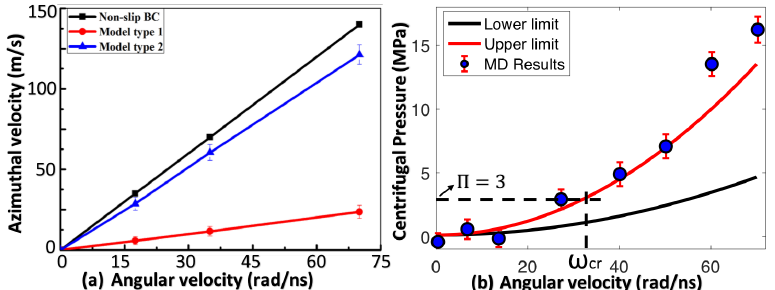
Figure 6. ( a ) Averaged azimuthal velocities of fluid near r = R i as a function of angular velocity ω for Model I and Model II. The curve “Non-slip BC” means v θ = R i ω . ( b ) Lower and Upper limits of the centrifugal pressure P ω derived from fluid dynamics and that obtained from MD